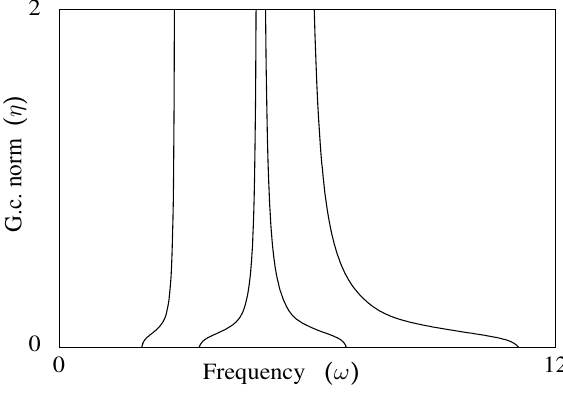
Figure 5. Process 2: σ - ω - η analysis with V = 0.